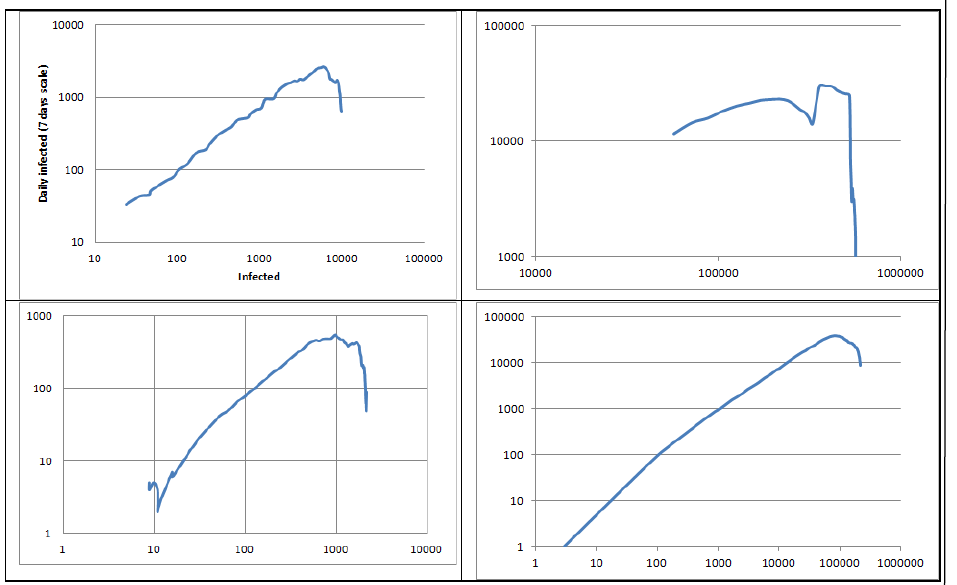
Figure 9 – Double logarithmic curve for a) Serbia, b) China, c) Croatia, and d) Italy,